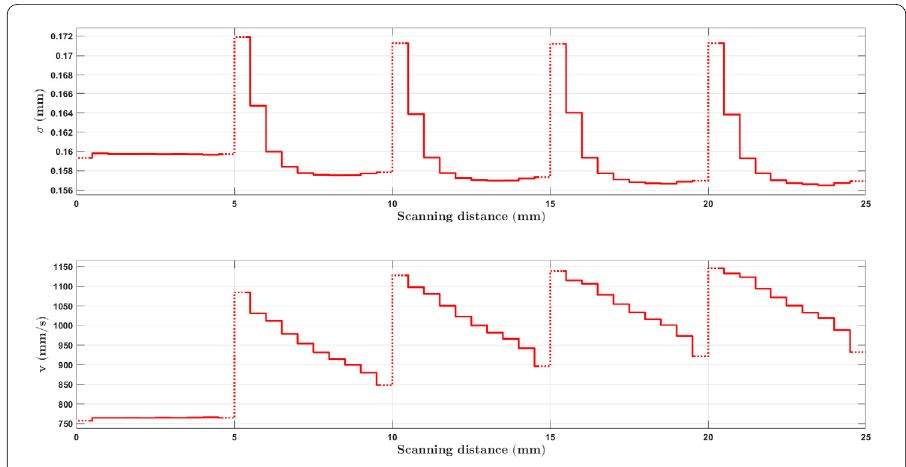
Figure 6 The solution as obtained by the first greedy algorithm. The dotted parts indicate the intervals where the weight α is 0 (the start and end of the hatch lines).